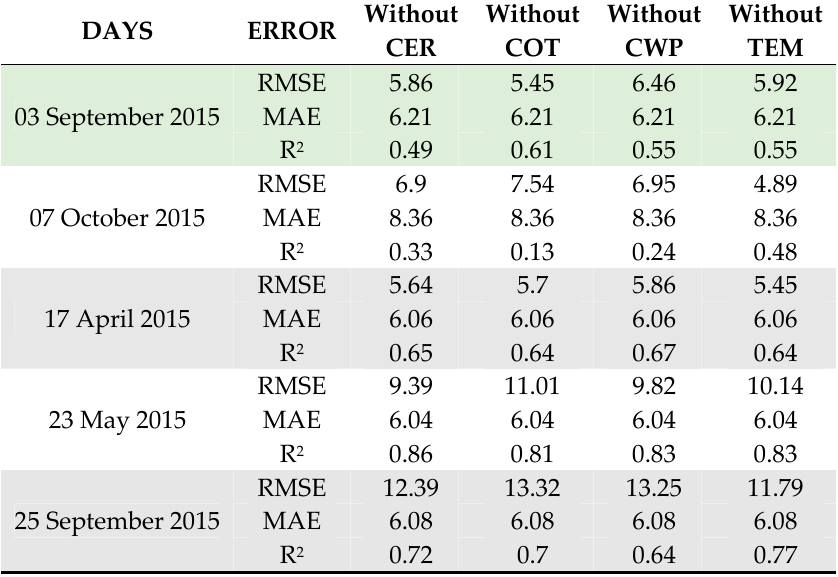
Table 8. Statistical indices after sensitivity analysis of daily precipitation estimates.